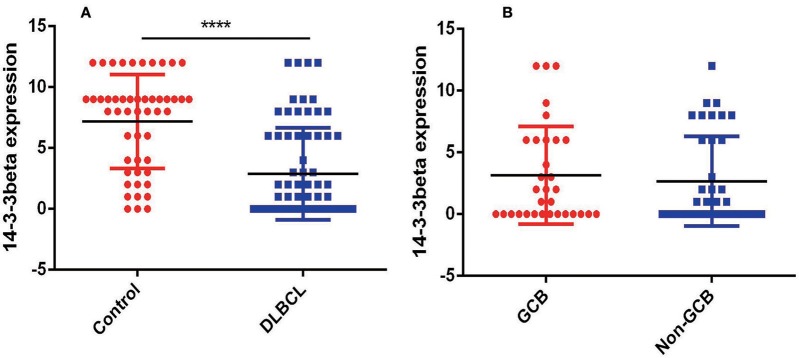
Comparison of 14-3-3 protein expression. (A) Expression in non-neoplastic lymph nodes and DLBCL tissues (****p < 0.0001). (B) Expression in GCB and Non-GCB DLBCL tissues (p = 0.5855).